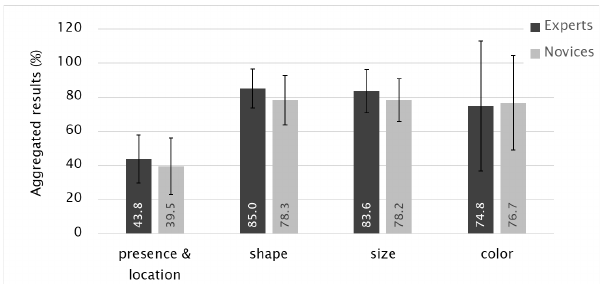
Figure 11. Color scores (Error bars indicate standard deviation).